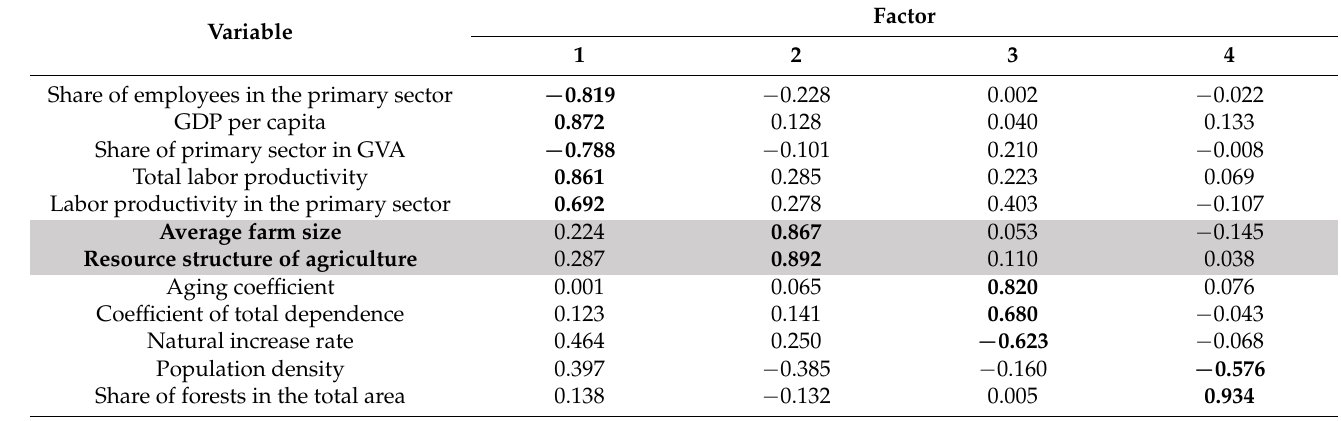
Table A1. Defined model on the NUTS 3 level: Serbia and